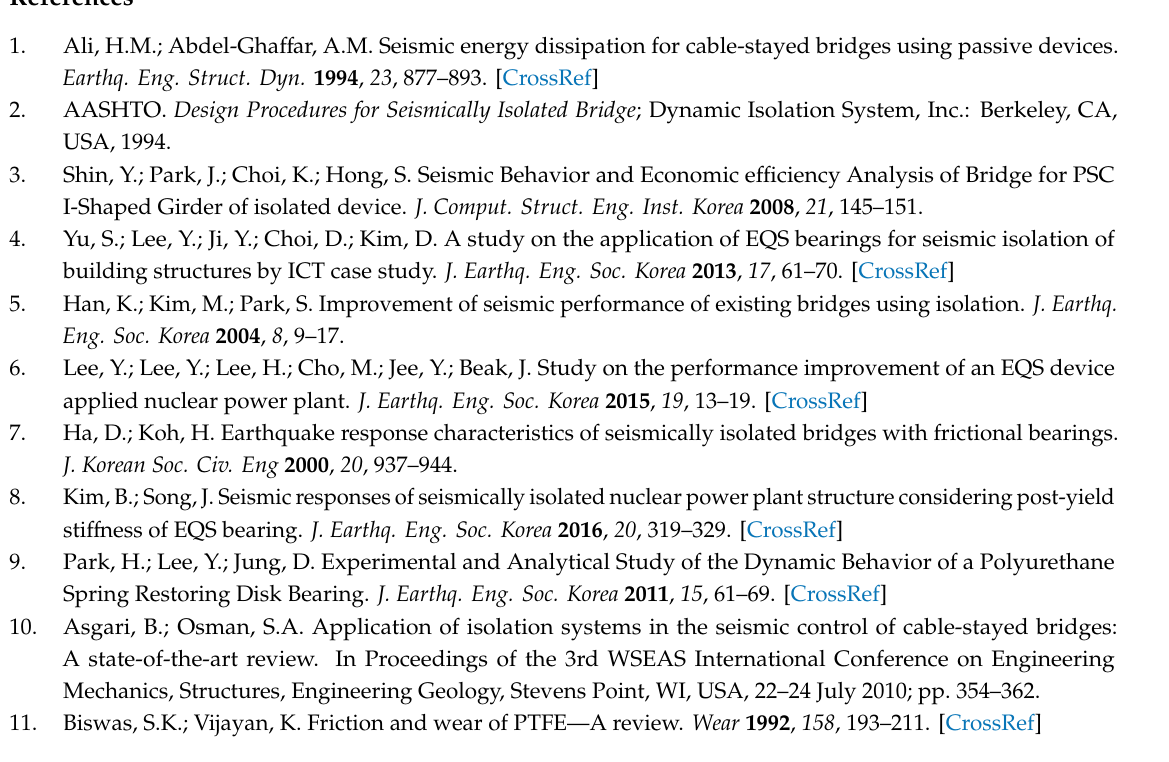
Figure A3. Proposed design procedure for R-FBI (Case III).